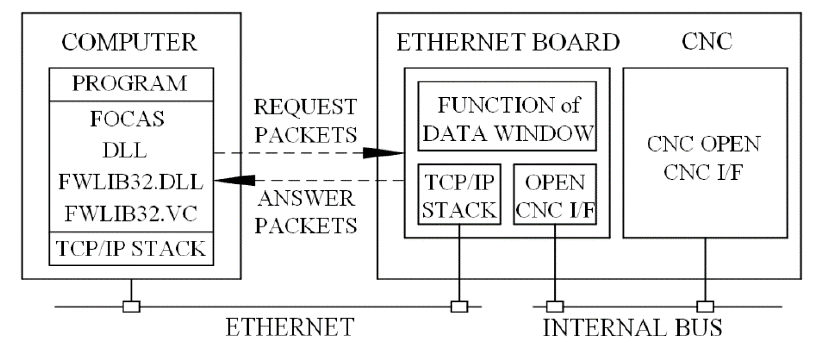
Figure 1. Experimental setup.